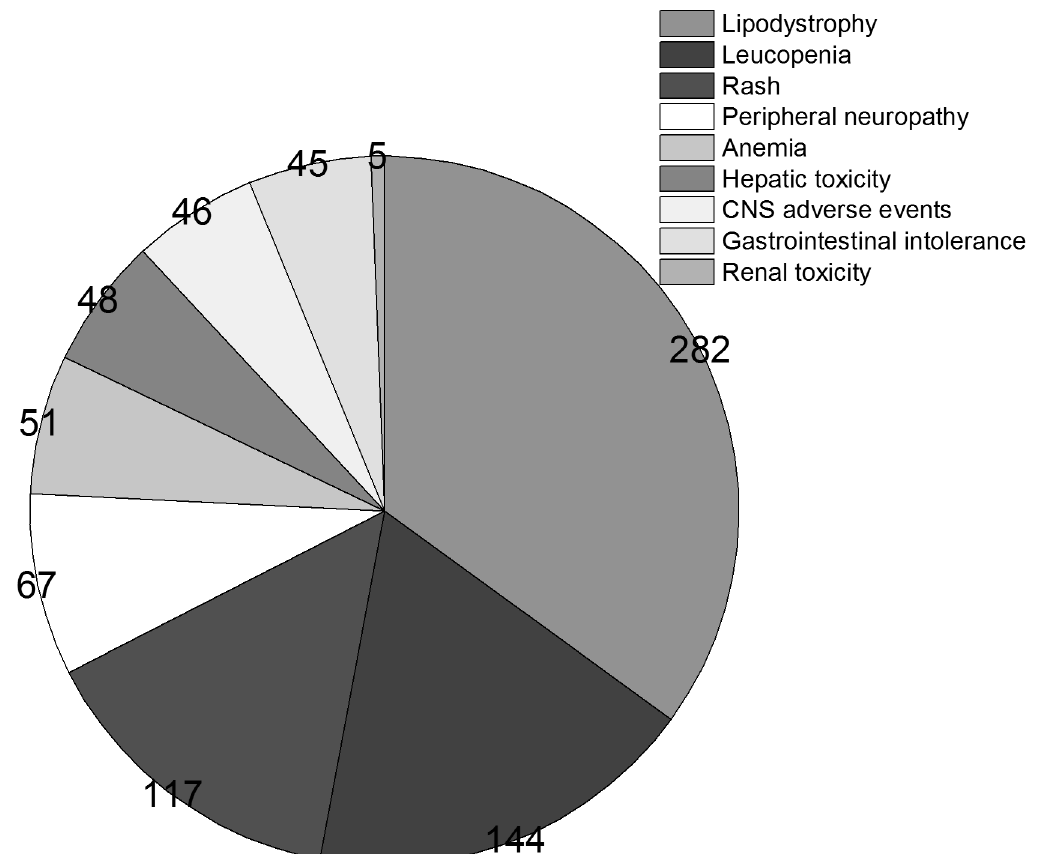
Fig 3. The detailed types of toxic